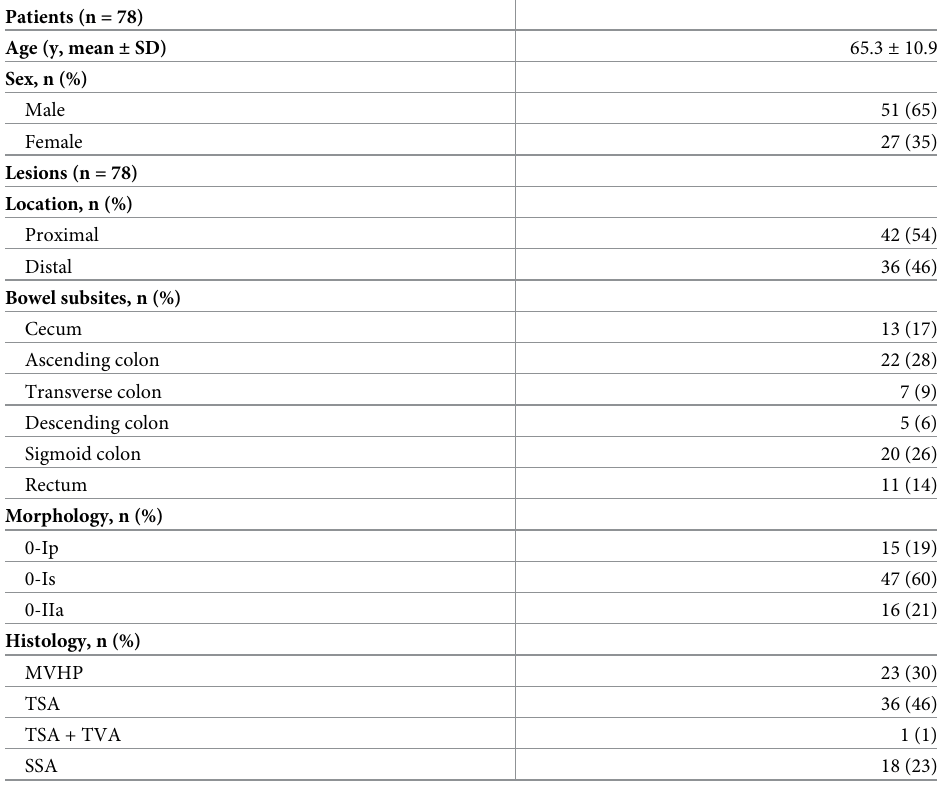
Table 1. Clinicopathological features of the serrated lesions in this